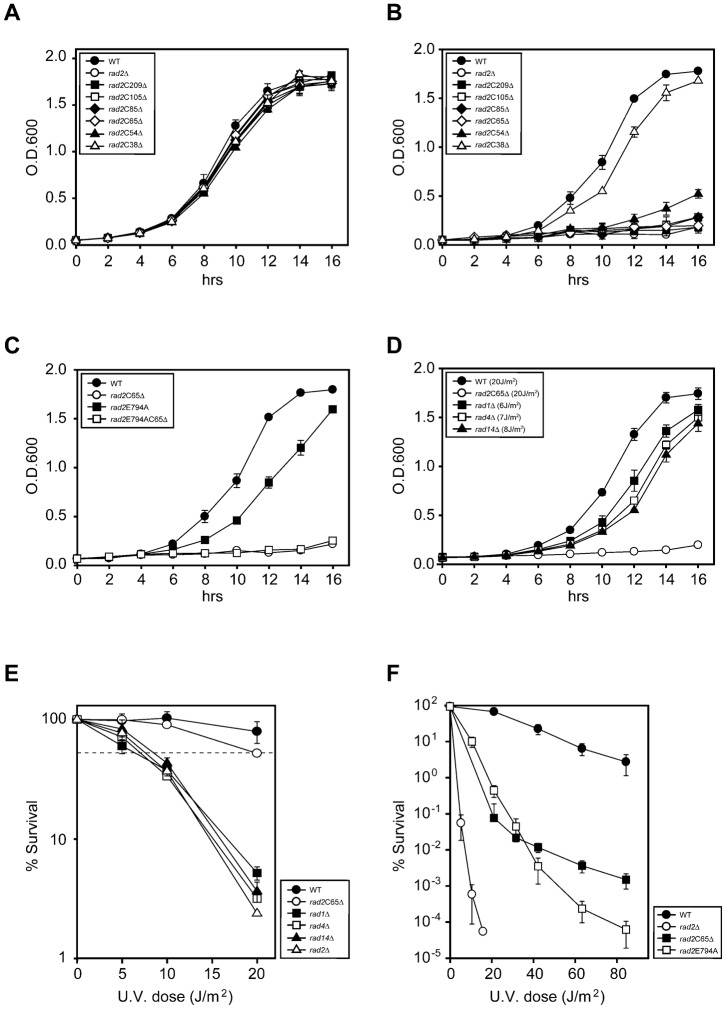
Growth of WT and mutant strains.(A) In the absence of UV irradiation, cell growth of all rad2 mutants was comparable to that of WT. (B) After 20 J/m2 of UV irradiation, the cell growth of all rad2CΔ mutants, except rad2C38Δ, was impaired. (C) After of UV irradiation, growth of rad2E794A was initially somewhat impaired; however, at 16 hours, its growth was comparable to that of WT. rad2E794AC65Δ refers the mutant with both the rad2E794A and rad2C65Δ mutation. (D) Cell growth of rad1Δ, rad4Δ, and rad14Δ mutants irradiated with equivalent toxic UV doses of 6, 7, and 8 J/m2 of UV, respectively, was elevated to levels significantly higher than that of rad2C65Δ mutant irradiated with 20 J/m2. (E) UV sensitivity of rad1Δ, rad4Δ, and rad14Δ mutants. The dotted line indicates 70% viability. (F) The survival rate of the rad2E794A mutant showed a linear decrease with increasing UV radiation. The survival rate of the rad2C65Δ mutant clearly decreased in response to 20 J/m2 UV radiation, but the dose-dependence of this decrease was significantly reduced at UV doses higher than 20 J/m2. Each curve represents an average of 3 or more experiments.